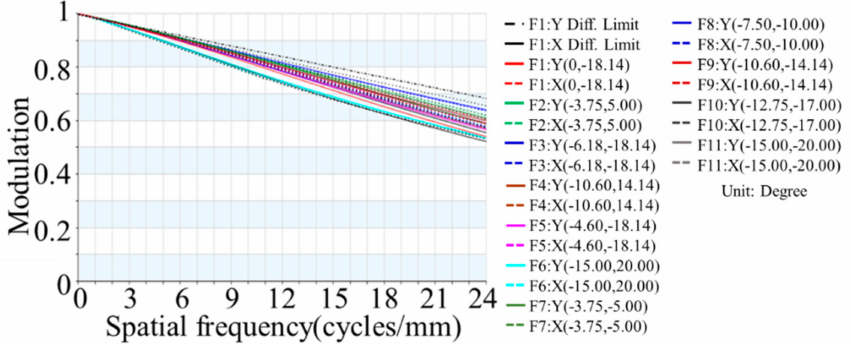
Figure 7. MTF chart in freeform